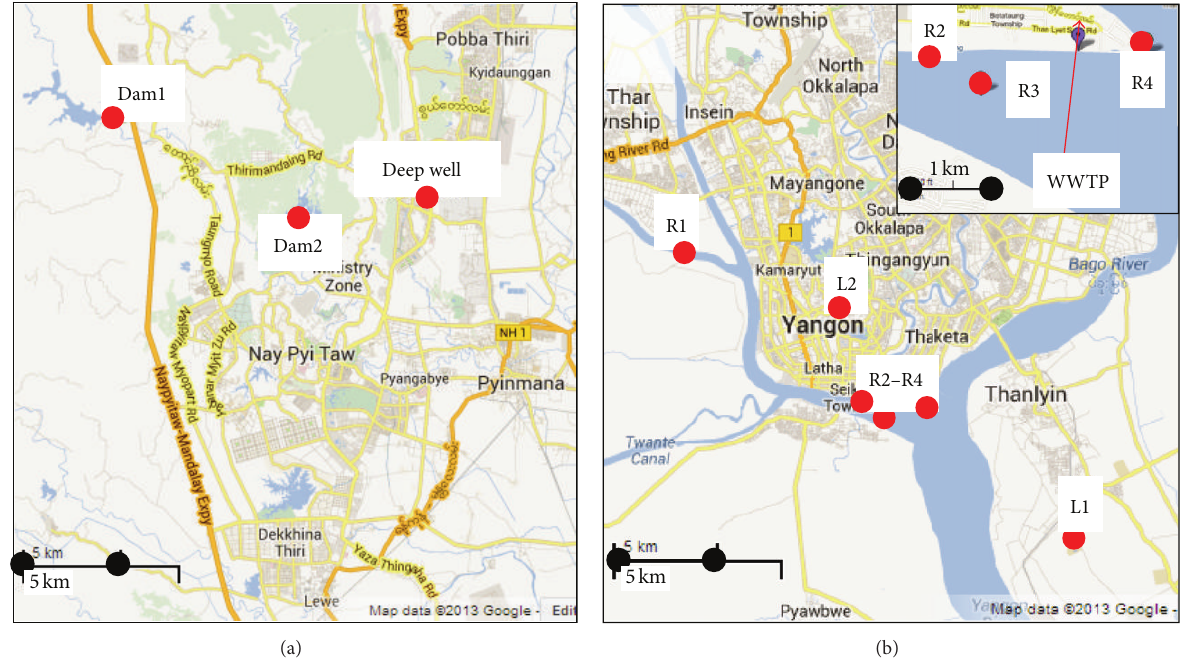
Figure 1: Maps of sampling locations in (a) Nay Pyi Taw and (b) Yangon.